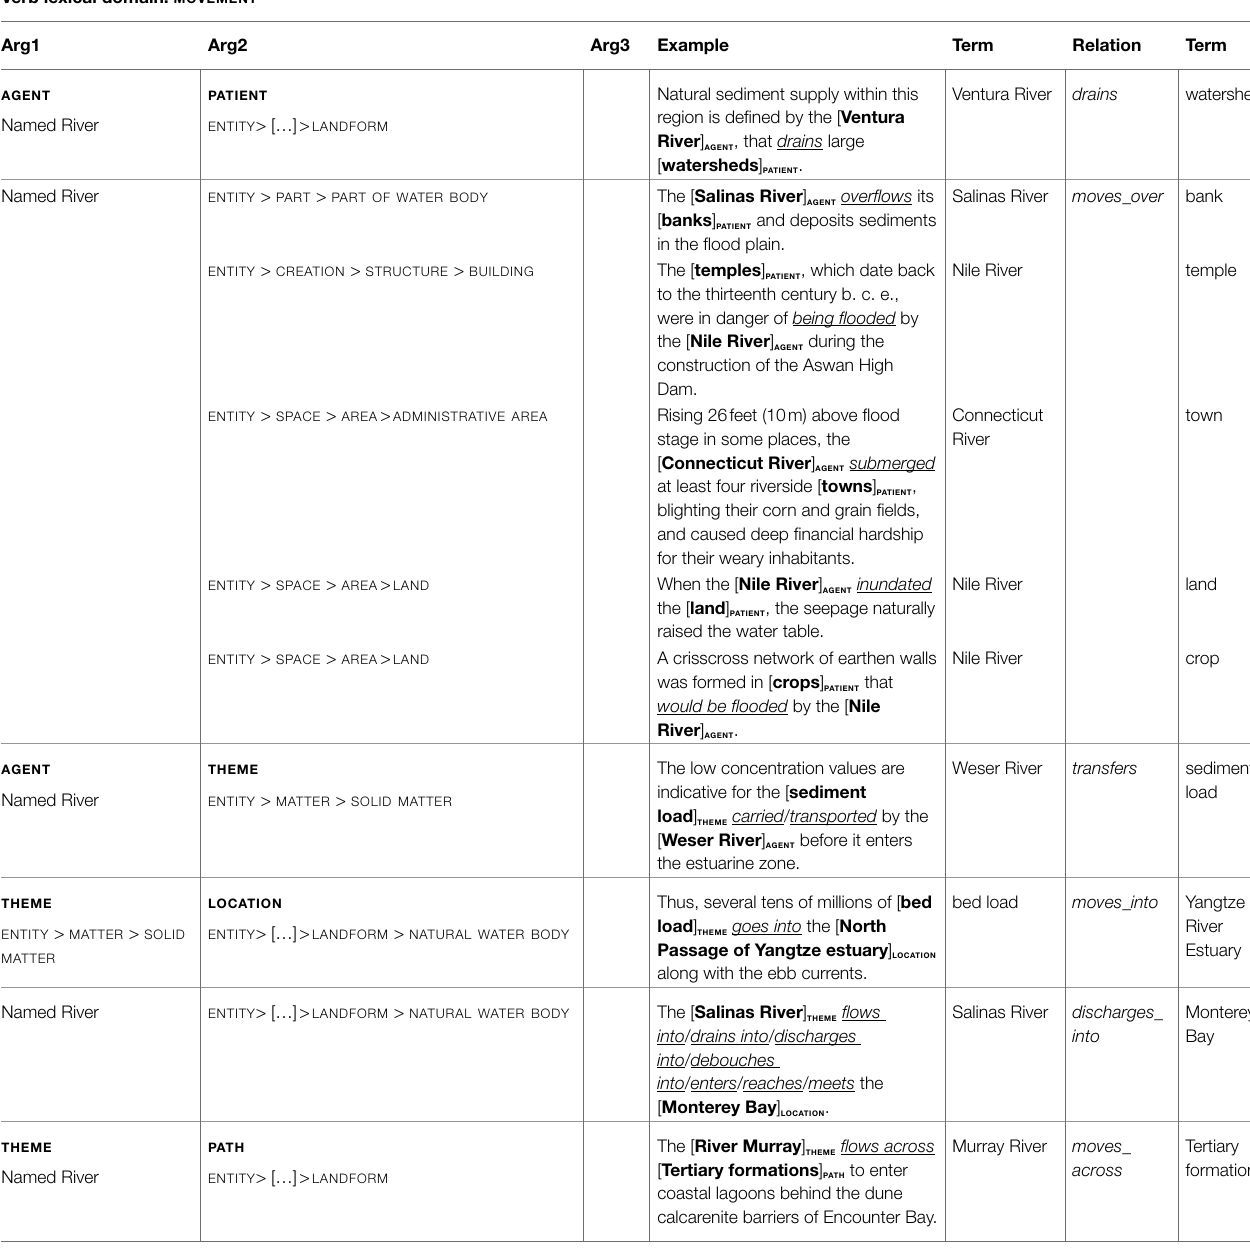
TABLE 4 | Results from the semantic annotations for the lexical domain of movement . Verb lexical domain: